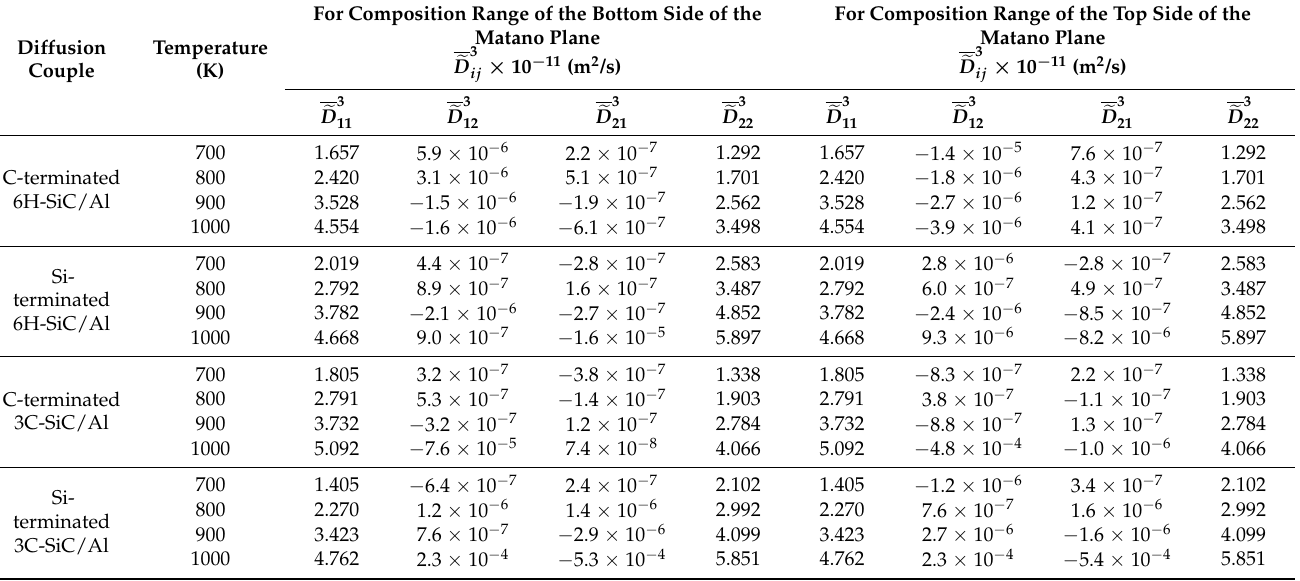
Table 3. Average values of ternary main and cross-interdiffusion coefficients on each side of the Matano plane after maintaining the system with 20% vacancy defects in SiC at the preset temperature for 6 ns (indices: 1 = Al; 2 = Si; and 3 =